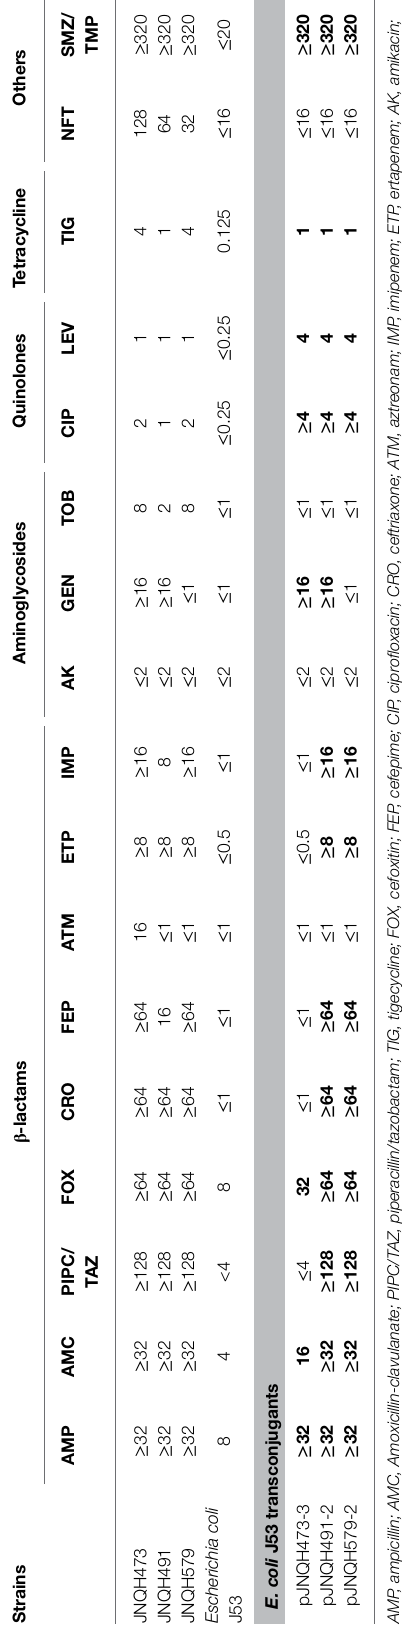
97.67, 97.61, and 99.79% amino acid identities between each TmexD , and ToprJ genes shared 94, 96.72, and 99.86% nucleotide identities and 97.12, 98.08, and 99.79% amino acid identities. ToprJ gene shares the highest similarity at the amino acid T A